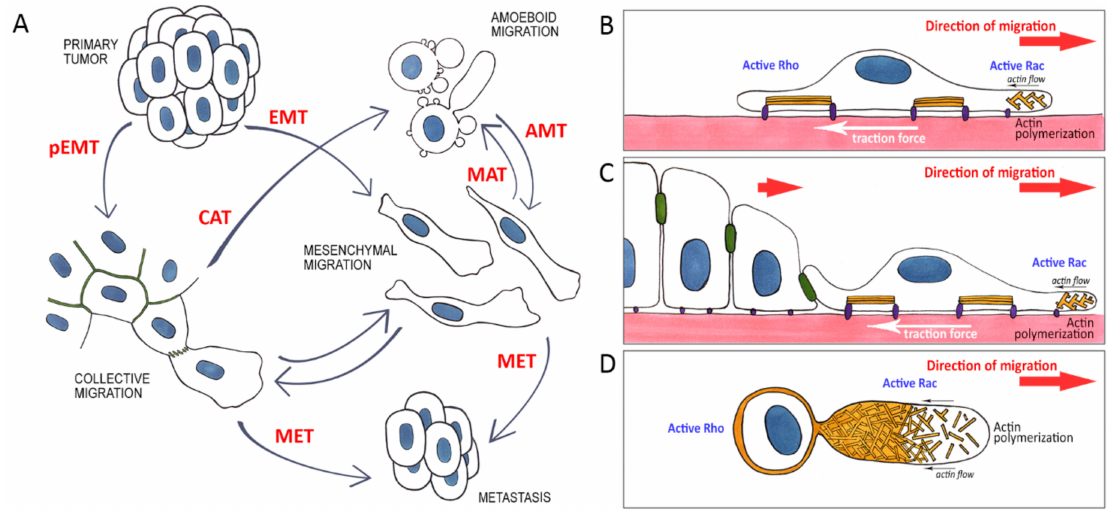
Figure 5. Plasticity of cancer cell migration. ( A )—A primary epithelial tumor through partial epithelial- mesenchymal transition (pEMT) or epithelial-mesenchymal transtion (EMT) gives rise to motile cells capable of invasion via individ- ual or collective mesenchymal migration. Specific microenvironment conditions govern reversible transitions between mesenchymal and amoeboid migration modes (collective-amoeboid transition (CAT), mesenchymal-amoeboid transition (MAT), amoeboid-mesenchymal transition (AMT)). In a distant metastasis, cells cease to migrate and revert to the original epithelial phenotype (mesenchymal-epithelial transition (MET)). ( B – D )—Modes of cancer cell migration. Reorganized actin cytoskeleton and relative activity of Rho and Rac in the front and rear of the cells during individual ( B ), collective ( C ), or amoeboid ( D )